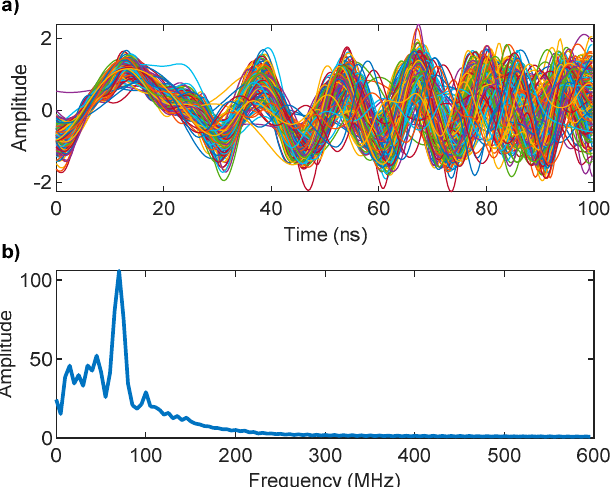
Figure 4. The 200 extracted low-frequency clutters from Chang’E-3 LPR data and its average fre- quency amplitude spectrum. ( a ) The extracted low-frequency clutters. ( b ) Average frequency am- plitude spectrum of the signals in (a).